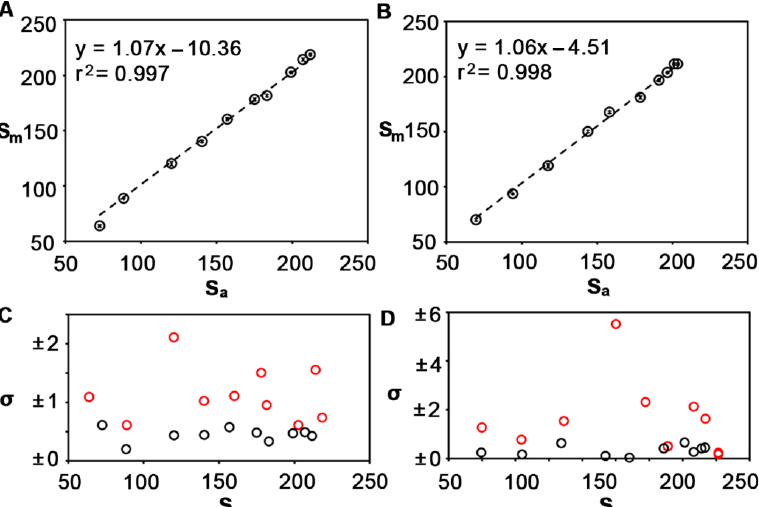
Figure 4. Comparison of smaller signals obtained using the manual method (S m ) or the automated method (S a ) for quantifying the pixel intensity. Correlation plots when the spots are shaped like a small circle ( A ), or a small rectangle ( B ), circles are the mean and error bars are the standard deviation ( n = 3). Standard deviation ( σ ) associated with colorimetric signals S obtained with the proposed software (black) or with the manual method (red) ( C , D ).